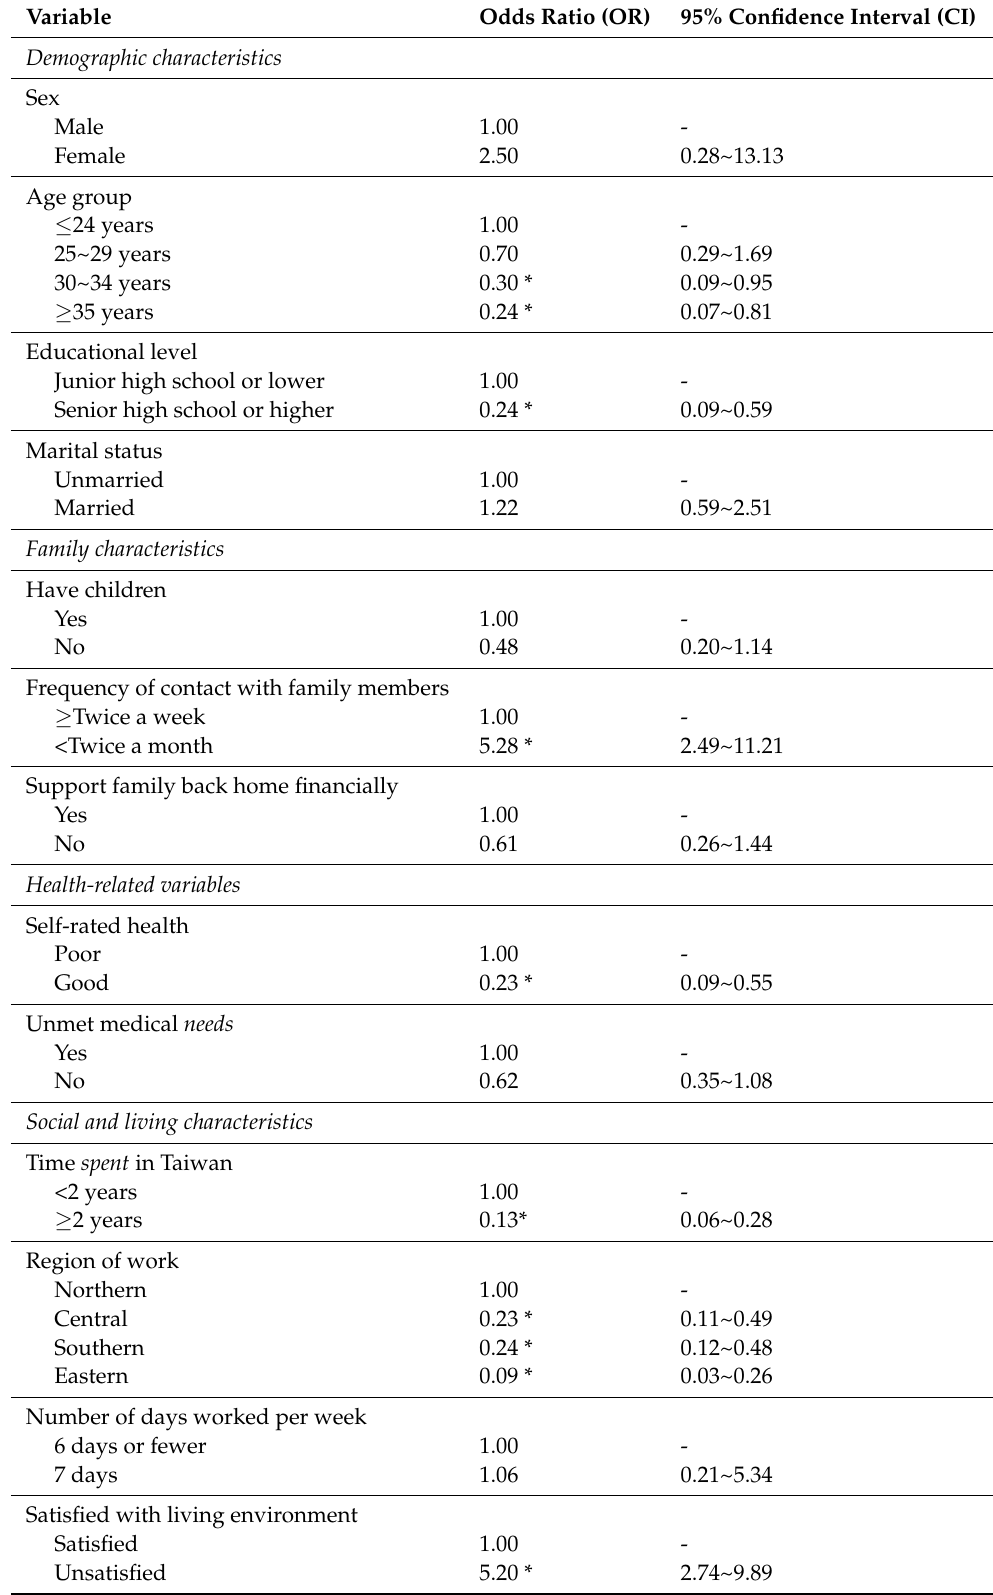
Table 3. Logistic regression of factors associated with depressive symptoms among Indonesian migrant workers in Taiwan.